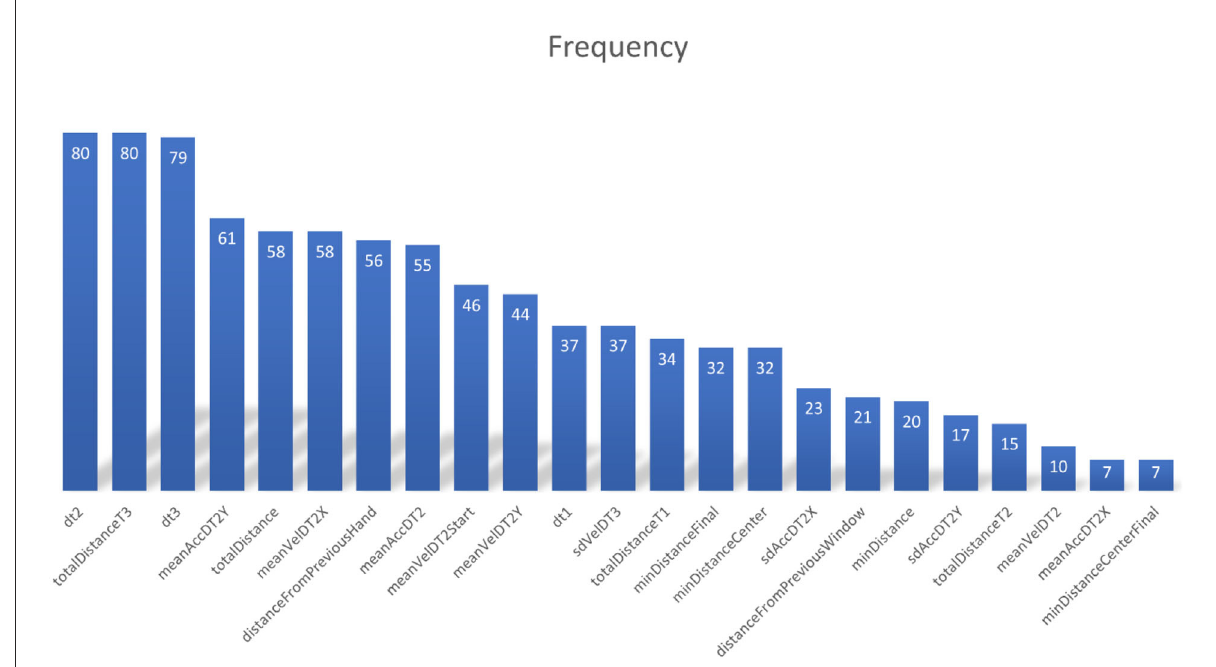
FIGURE14 Feature selection rate, defined as the number of times each feature is selected in the model, during the training phase with different training